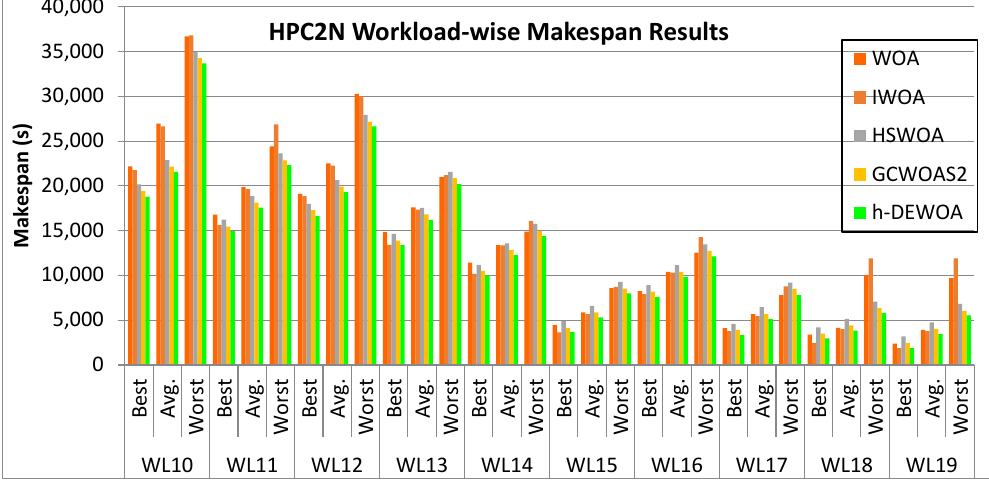
Figure 8. Statistical results of the energy consumption metric for WL0–WL9 workloads. Workload-Wise Makespan Results for HPC2N Workloads The h-DEWOA algorithm also produces very good results against WOA-based baseline techniques for HPC2N workloads as shown in Figure 9.